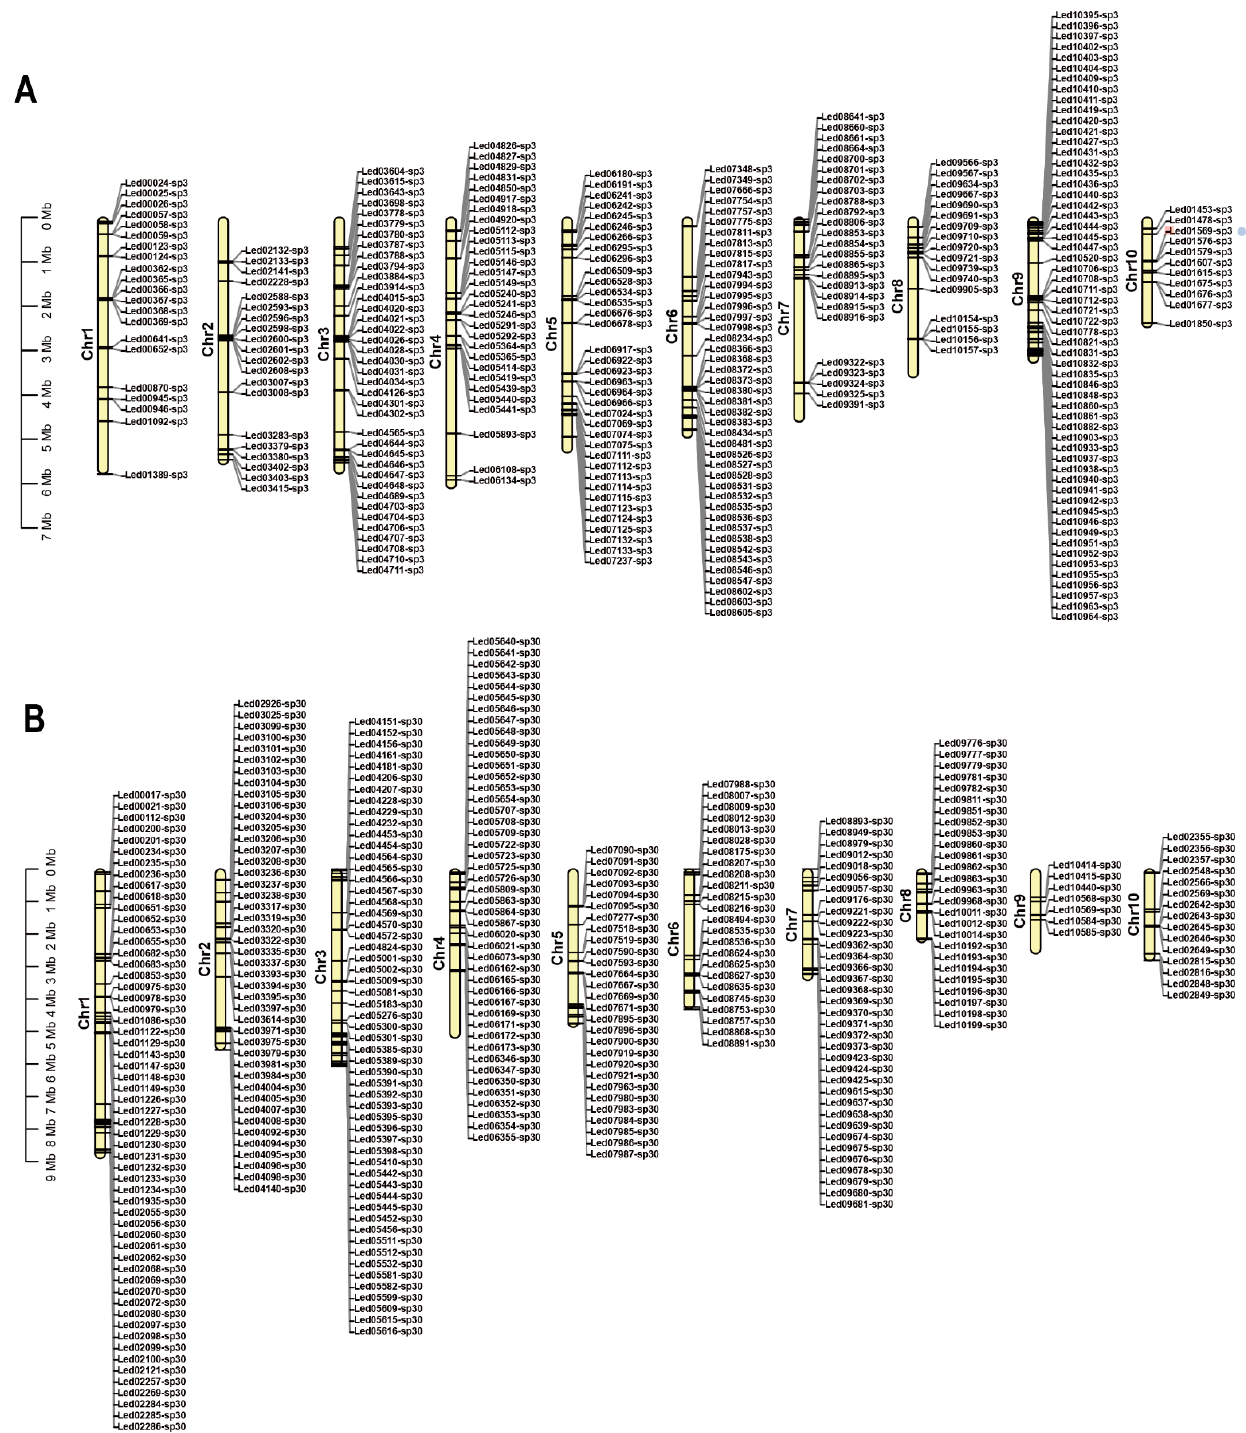
Figure 5. Location of the unique genes found within each of the two monokaryons on each chromo- some. ( A ) Unique genes in strain SP3. ( B ) Unique genes in strain SP30.